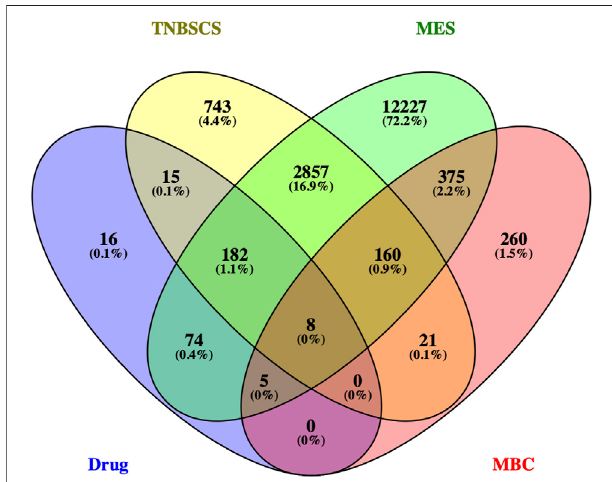
FIGURE 5 | Venn diagram of the target genes for active compounds of Xihuang pill, TNBC stem cells, and mesenchymal-like (MES) subtype ofTNBC and the signi fi cant genes of metaplastic breast cancer. Active compounds of Xihuang pill has 300 target genes, TNBC stem cell has 3,968 related target genes, the mesenchymal-like (MES) subtype of TNBC has 15,888 target genes, and metaplastic breast cancer has 829 signi fi cant genes. There are eight overlapping target genes between the four sets: CHUK, CLDN4, ITGAM, JUN, NR3C2, PPARD, RASA1, and RUNX2.